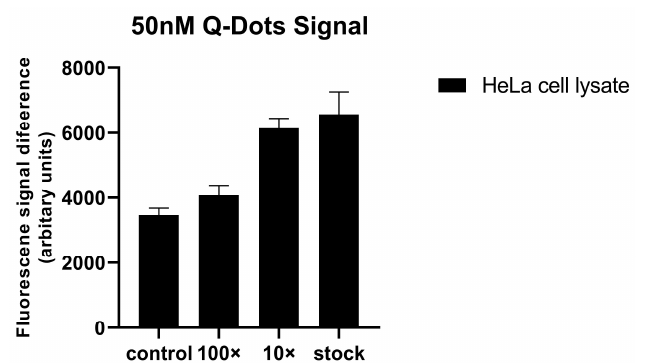
Figure 8. Fluorescence signal difference in Sav-QDs’ after spotting and after incubation with biotinylated HSP90 antibody and HeLa cell lysate plotted against different dilutions of HeLa cell lysate. Control is only 1 × PBS buffer.